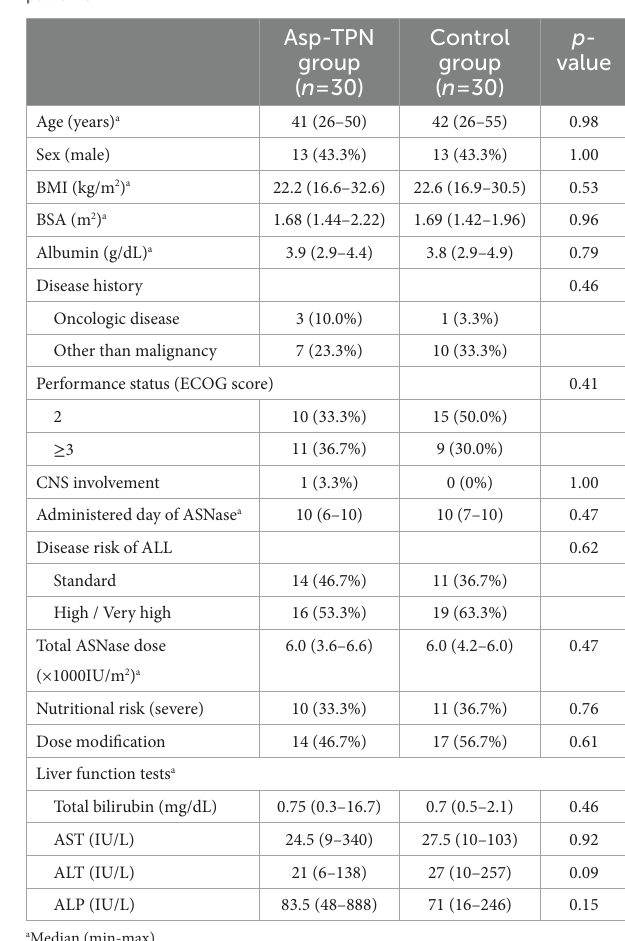
TABLE 1 Baseline characteristics of the propensity score-matched